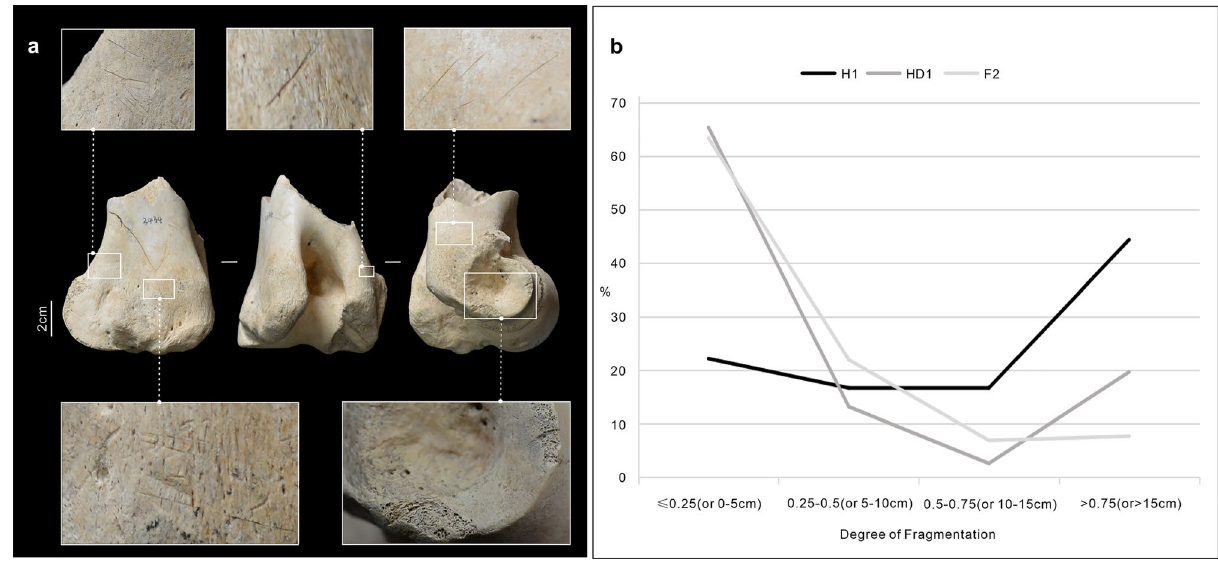
Figure 6. ( a ) Cut marks and their location on cattle humerus distal end. Photograph credit: Y. X. ( b ) Degree of fragmentation in different features (H1 and HD1) of F2 compared with faunal remains from all other contexts. Proportion of bone has been used for identified bones, while cm is used for unidentified